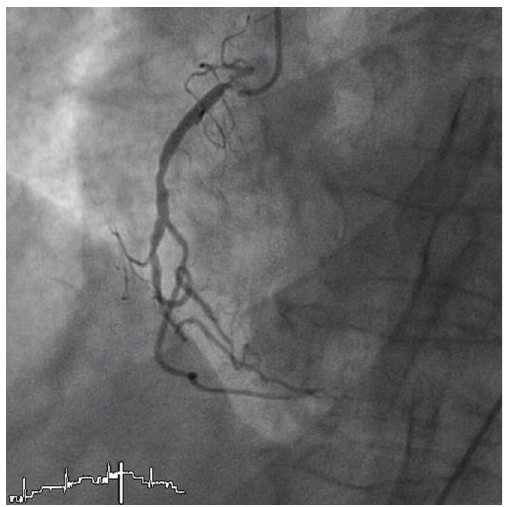
Figure 3: Coronary angiography revealing a 50% stenosis in the right coronary artery.